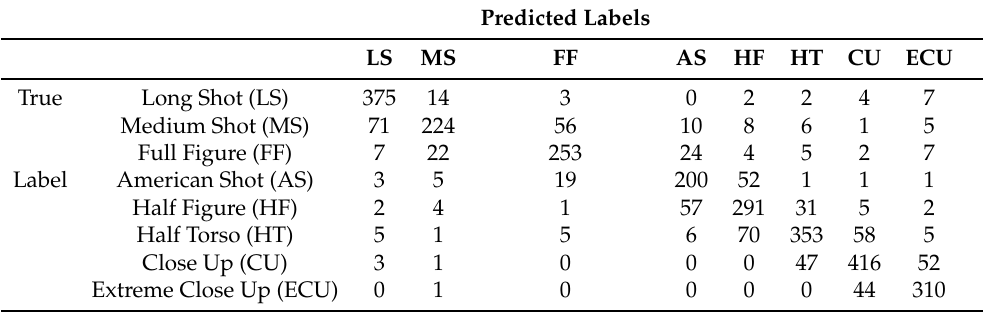
Table 8. Confusion Matrix of a VGG-16 trained on the augmented Original Dataset with the flip on the y-axis, i.e., Scenario 1.